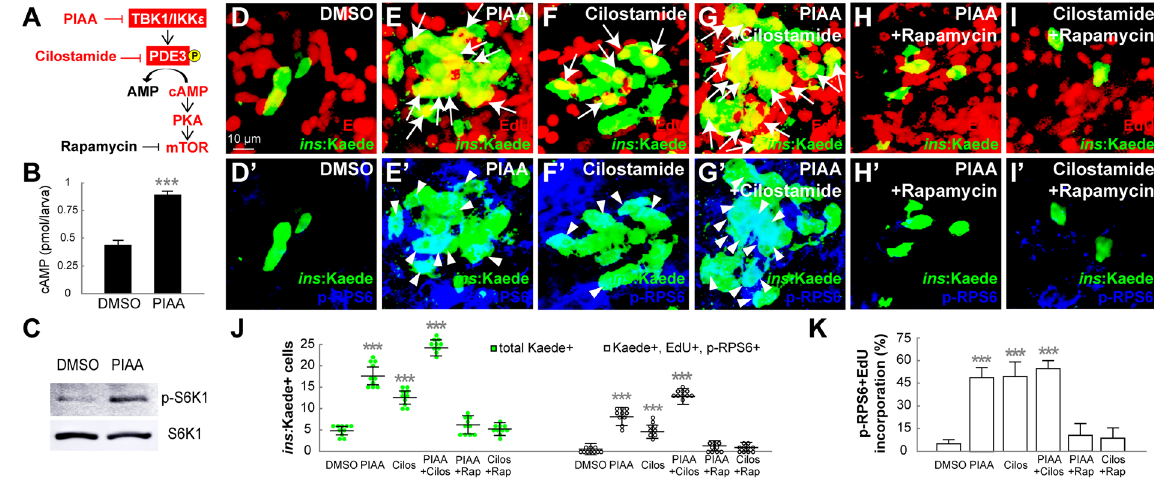
Figure 6. Suppression of the TBK1/IKK ε -PDE3 signaling axis promotes β -cell proliferation by increasing cAMP levels and mTOR activity. ( A ) Schematic of the TBK1/IKK ε -PDE3 signaling that modulates cAMP- PKA-mTOR pathway. The sites of inhibition by PIAA and cilostamide are shown in red. ( B ) Quantification of cAMP levels (mean ± SD) at 48 hpa (0.4 ± 0.1 pmol/larva (DMSO) and 0.9 ± 0.0 pmol/larva (PIAA)). ( C ) Representative Western blot showing increased pS6K1 levels in PIAA-treated recovering larvae. ( D-I’ ) Confocal images of [ Tg ( ins:CFP-NTR ) s892 ; Tg ( ins:Kaede ) jh6 ] larvae at 48 hpa, concurrently treated with EdU and DMSO ( D-D’ ), PIAA ( E-E’ ), cilostamide ( F-F’ ), a combination of PIAA and cilostamide ( G-G’ ), a combination of PIAA and rapamycin ( H-H’ ), or a combination of cilostamide and rapamycin ( I-I’ ), respectively, from 0–48 hpa, stained for pRPS6 (blue). The number of EdU-incorporated (white arrows) and pRPS6-positive (white arrowheads) β -cells was increased in recovering larvae treated with both PIAA and cilostamide ( G , G’ ) compared to individual compound-treated larvae ( E-E’ and F-F’ ). Rapamycin substantially suppressed the PIAA- and cilostamide-dependent increases in the number of EdU-incorporated and pRPS6-positive β -cells ( H-I’ ). ( J ) Quantification of the number (mean ± SD) of total regenerated β -cells (green bars) and regenerated β -cells that incorporated EdU with pRPS6 immunoreactivity (white bars) at 48 hpa (in D-I’; 5.0 ± 1.3 total regenerated β -cells, of which 0.3 ± 0.5 (DMSO), 17.8 ± 2.8, of which 8.4 ± 1.7 (PIAA), 12.7 ± 1.9, of which 5.0 ± 1.5 (cilostamide), 24.7 ± 1.2, of which 13.3 ± 0.6 (PIAA and cilostamide), 6.0 ± 2.0, of which 1.0 ± 1.0 (PIAA and rapamycin), and 5.2 ± 1.1, of which 0.8 ± 0.8 (cilostamide and rapamycin) incorporated EdU with pRPS6 immunoreactivity). ( K ) The percentage (mean ± SD) of regenerated β -cells that incorporated EdU with pRPS6 immunoreactivity at 48 hpa (in D-I’; 6.1 ± 9.5% (DMSO), 47.3 ± 7.5% (PIAA), 50.4 ± 8.8% (cilostamide), 54.2 ± 4.2% (PIAA and cilostamide), 13.9 ± 12.7% (PIAA and rapamycin), and 13.7 ± 13.0% (cilostamide and rapamycin)). Cells in 20 planes of confocal images from 10 individual larvae were counted per condition. *** P <